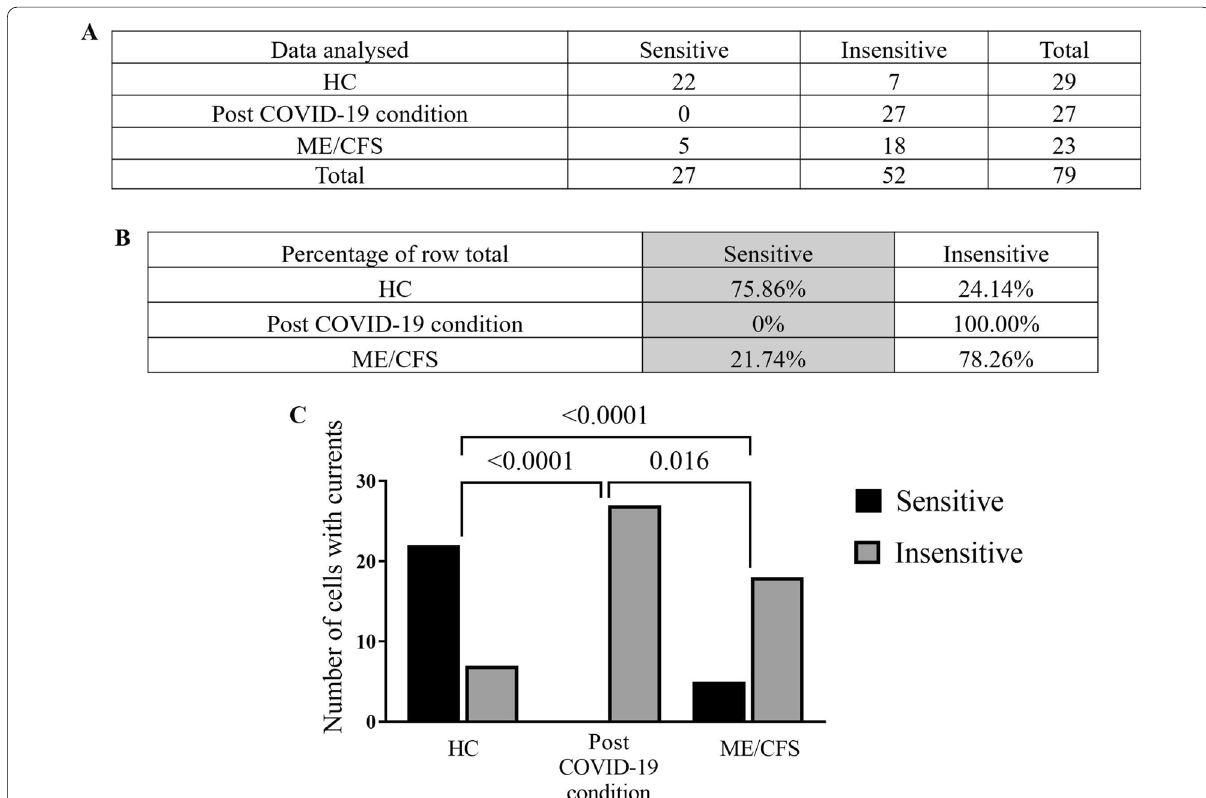
Fig. 3 Summary TRPM3 activity after ononetin modulation. Data were obtained under whole‑cell patch‑clamp conditions. Table summarizing data for sensitive and insensitive cells to 10 μ Μ ononetin, ( A ) absolute number and ( B ) percentage. C Bar graphs representing sensitive and insensitive cells to 10 μ Μ ononetin, HC patients (N 5; n 29) compared with post COVID‑19 condition patients (N = = n 23). Data are analysed using Fisher’s exact test. N refers to number of participants and n to number of records analysed. HC healthy controls, ME/ = CFS myalgic encephalomyelitis/chronic fatigue